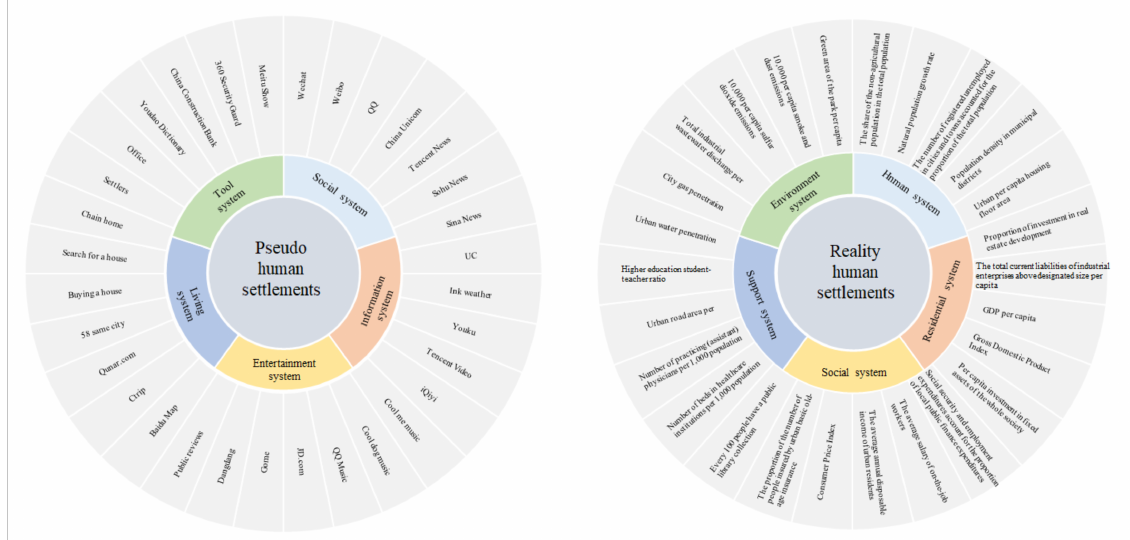
Figure 3. The coupling coordination index system diagram of urban PHSs and